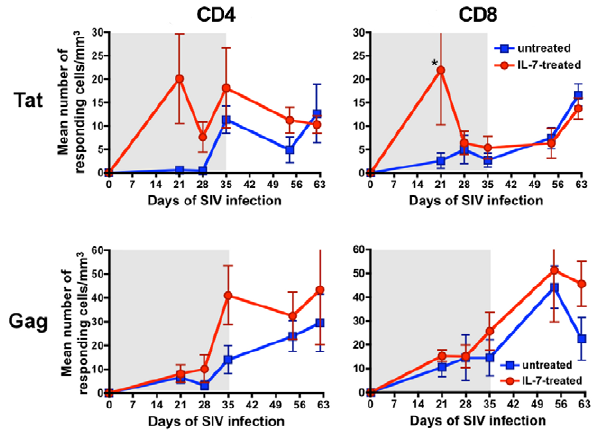
Figure 6. SIV-specific T-cell responses in untreated and IL-7- treated macaques. Mean absolute numbers ( 6 SEM) of total CD4 + and CD8 + T cells responding to overlapping peptides derived from the Tat and Gag proteins of SIV in untreated (blue) and IL-7-treated (red) animals. The asterisk indicates a significant difference between total responses in IL-7-treated vs. untreated